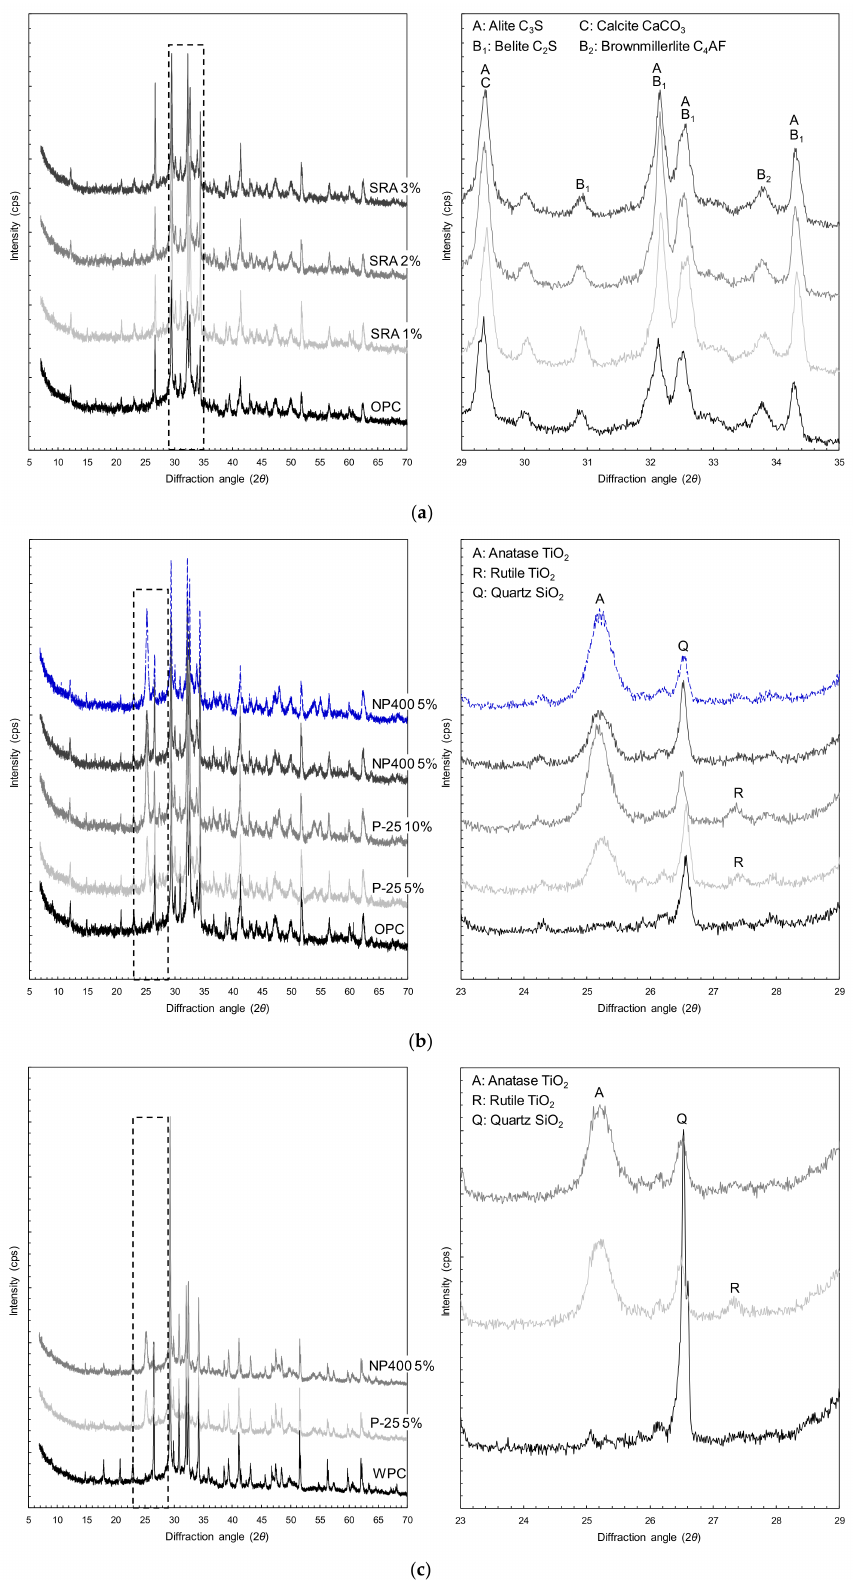
Figure 12. XRD patterns: ( a ) the e ff ect of the SRA, ( b ) the e ff ect of the TiO 2 powders, and ( c ) the e ff ect of the hybrid use of the white Portland cement and the TiO 2